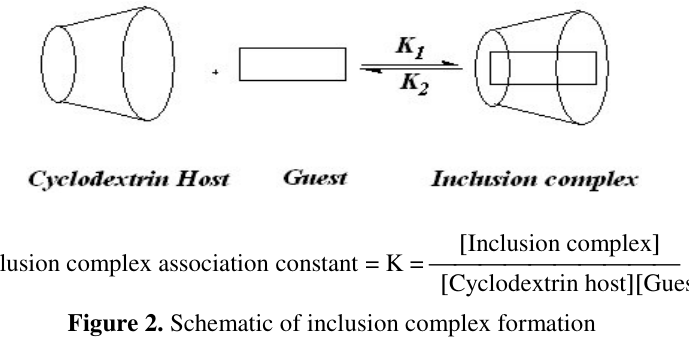
Figure 2. Schematic of inclusion complex